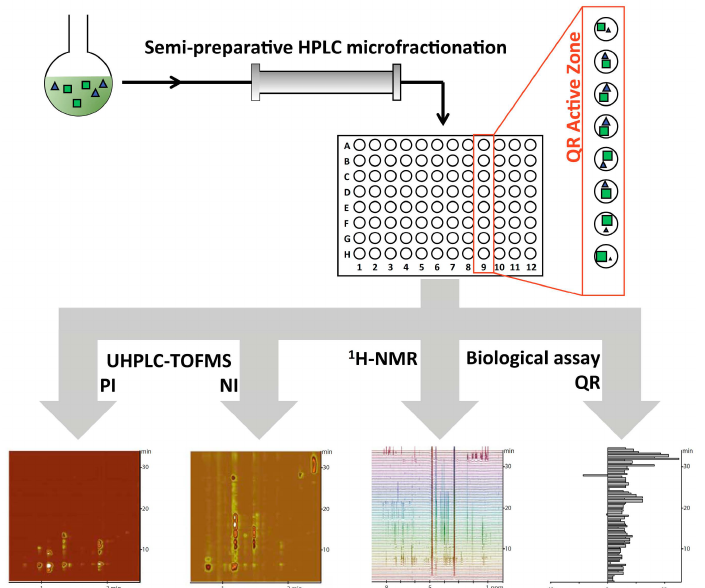
Figure 1. General strategy to evaluate statistical correlations for deconvolution of spectral